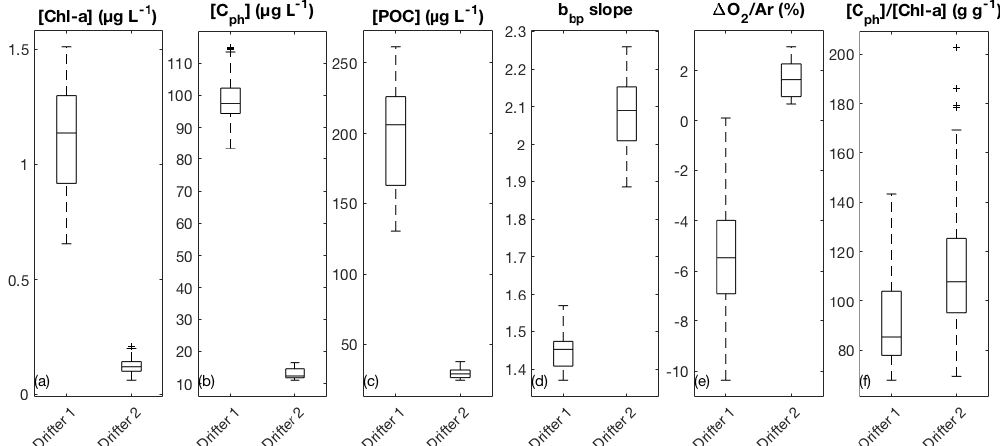
Figure 2. Comparison of average surface water properties between the two drifter deployments: (a) chlorophyll- a concentration (Chl- a ), (b) phytoplankton carbon concentration ( C ph ), (c) particulate organic carbon (POC) concentration, (d) the wavelength-dependent slope of particulate backscatter ( b bp ), (e) biological oxygen saturation anomaly ( (cid:49) O 2 / Ar), and (f) the [ C ph ] / [Chl- a ] ratio. Boxes represent the median (centerline) and 25th and 75th percentiles (box edges). Outliers are indicated as black plus ( + ) signs.